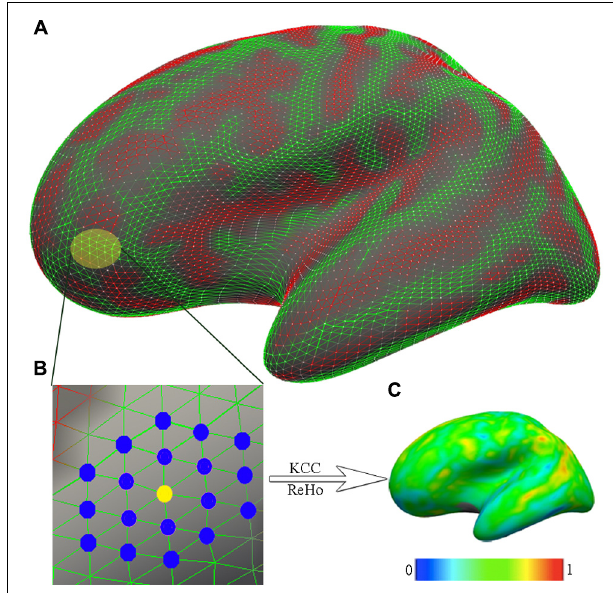
FIGURE 1 |The computation of functional homogeneity on the cortical surface. (A) The geometry of the cortical surface (e.g., here, the lateral cortical surface of the left hemisphere). (B) The preprocessed R-fMRI data are projected onto vertices of the cortical surface. For a given vertex (yellow node), which is indicated as the light yellow patch in (A) and magnified in (B) , the nearest neighbors are colored blue. Based on R-fMRI time series from all 19 vertices, the Kendall’s coefficient of concordance (KCC) of the center vertex is calculated as the regional homogeneity (ReHo). (C) Such calculations are repeated for all vertices on the surface to produce individual vertex-wise KCC-ReHo surface maps.The color map indicates the intensities of the KCC